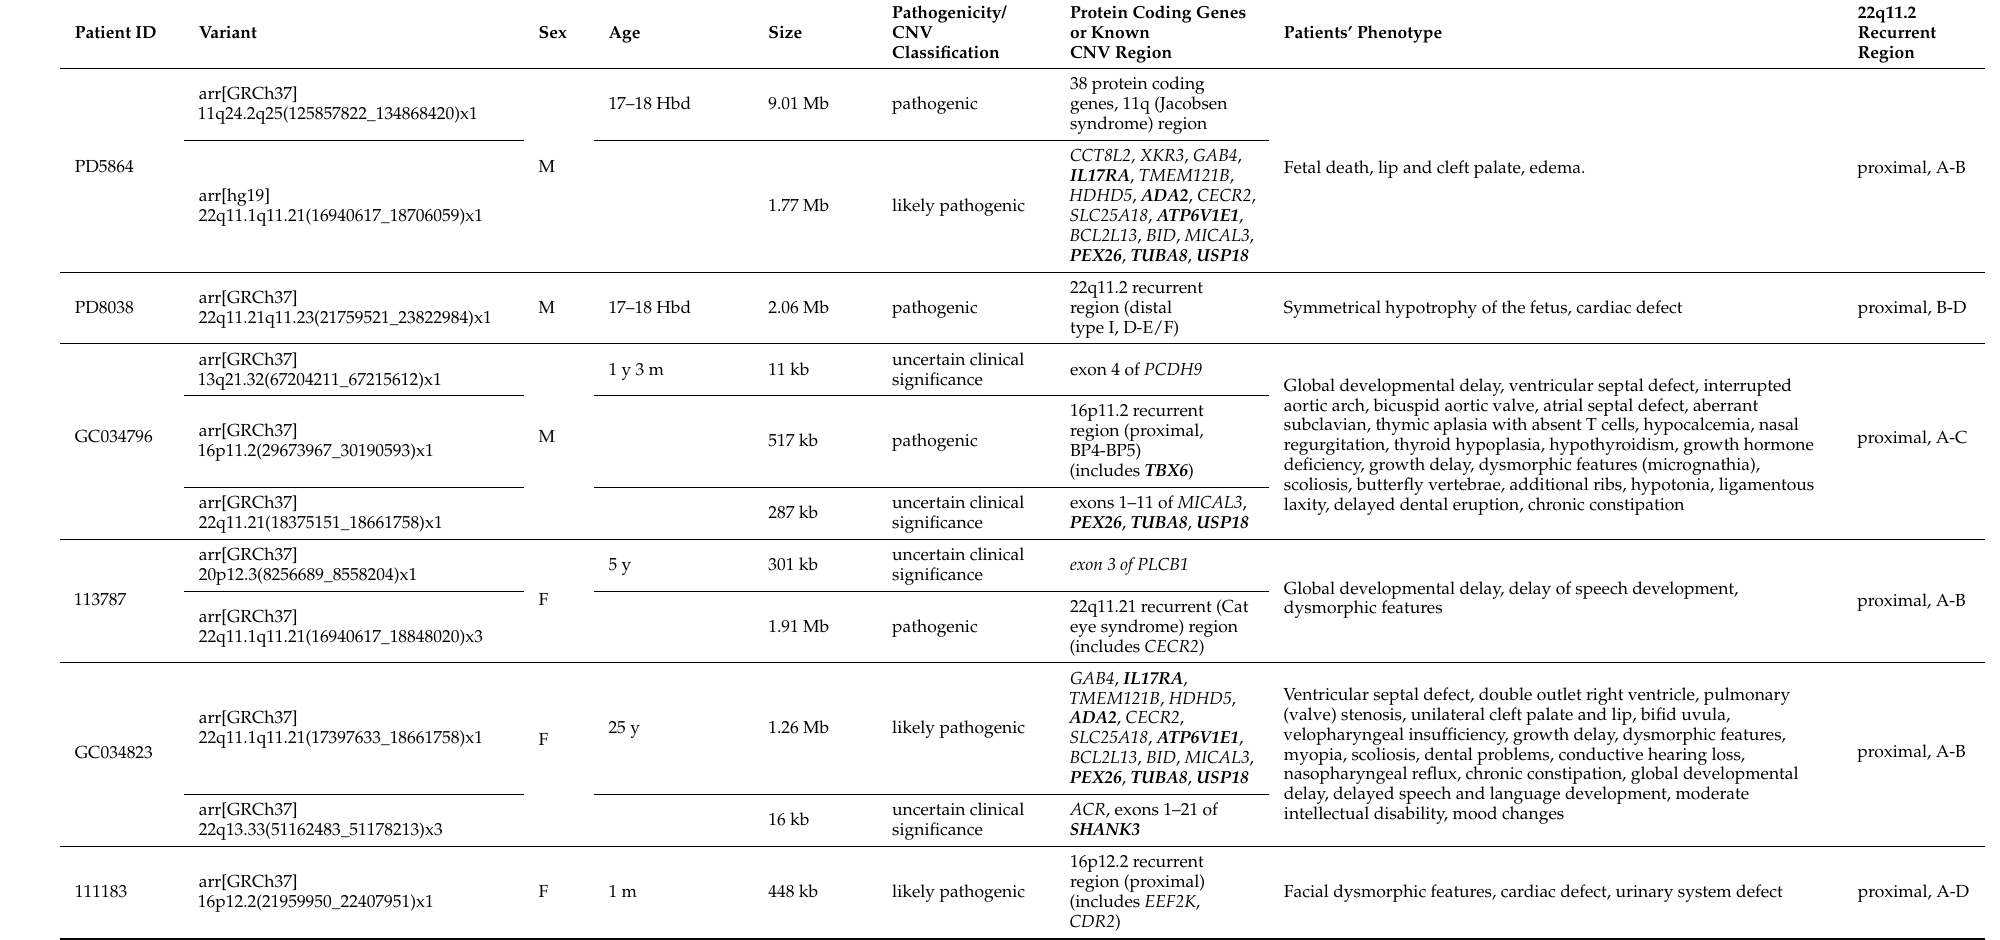
Table 1. Copy number variants identified in 159 (82 prenatal cases and 77 postnatal patients) patients, in addition to the 22q11 deletion. CNVs were classified as pathogenic, likely pathogenic, and of uncertain significance (VOUS) based on clinical data in known, free-access CNV databases. OMIM morbid genes are